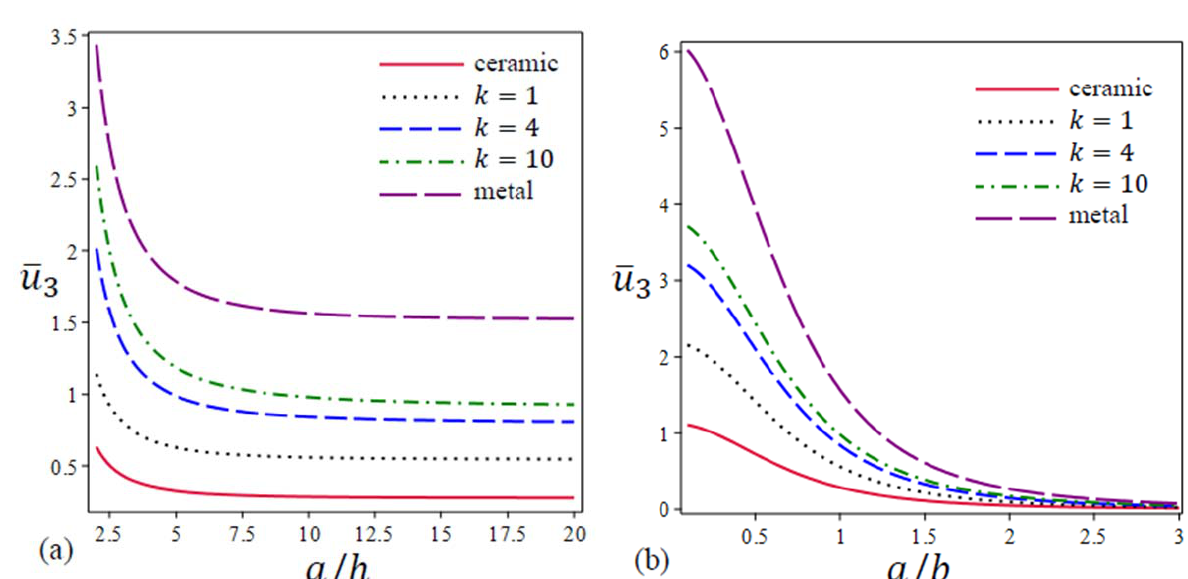
Figure 2: Non-dimensional displacement u 3 as: (a) function of a / h , (b) function of a / b